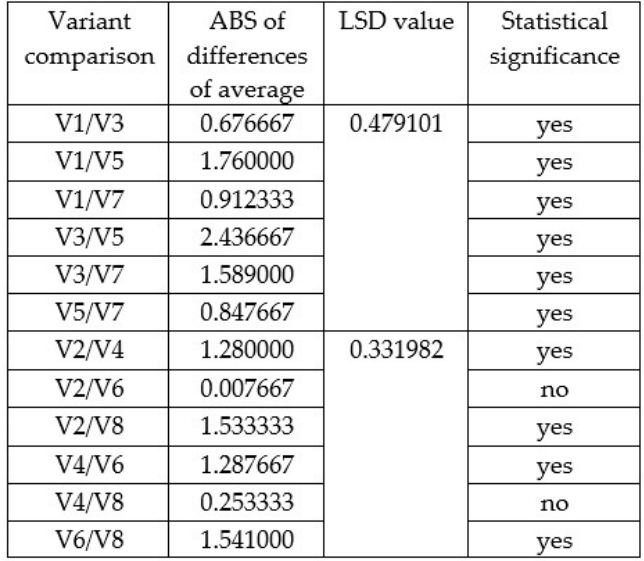
Figure 9. The statistical significance determined by LSD (Least Significant Difference) test values of Lepidium sativum L. sprouts weight on gauze (V1 control, illuminated with sunlight; V3, illuminated with white LED; V5, illuminated with blue LED; and V7, illuminated with red LED experimental variant) or biochar (V2 control, illuminated with sunlight; V4, illuminated with white LED; V6, il ‐ luminated with blue LED; and V8, illuminated with red LED experimental variant,) t crit value = 1.980626002.